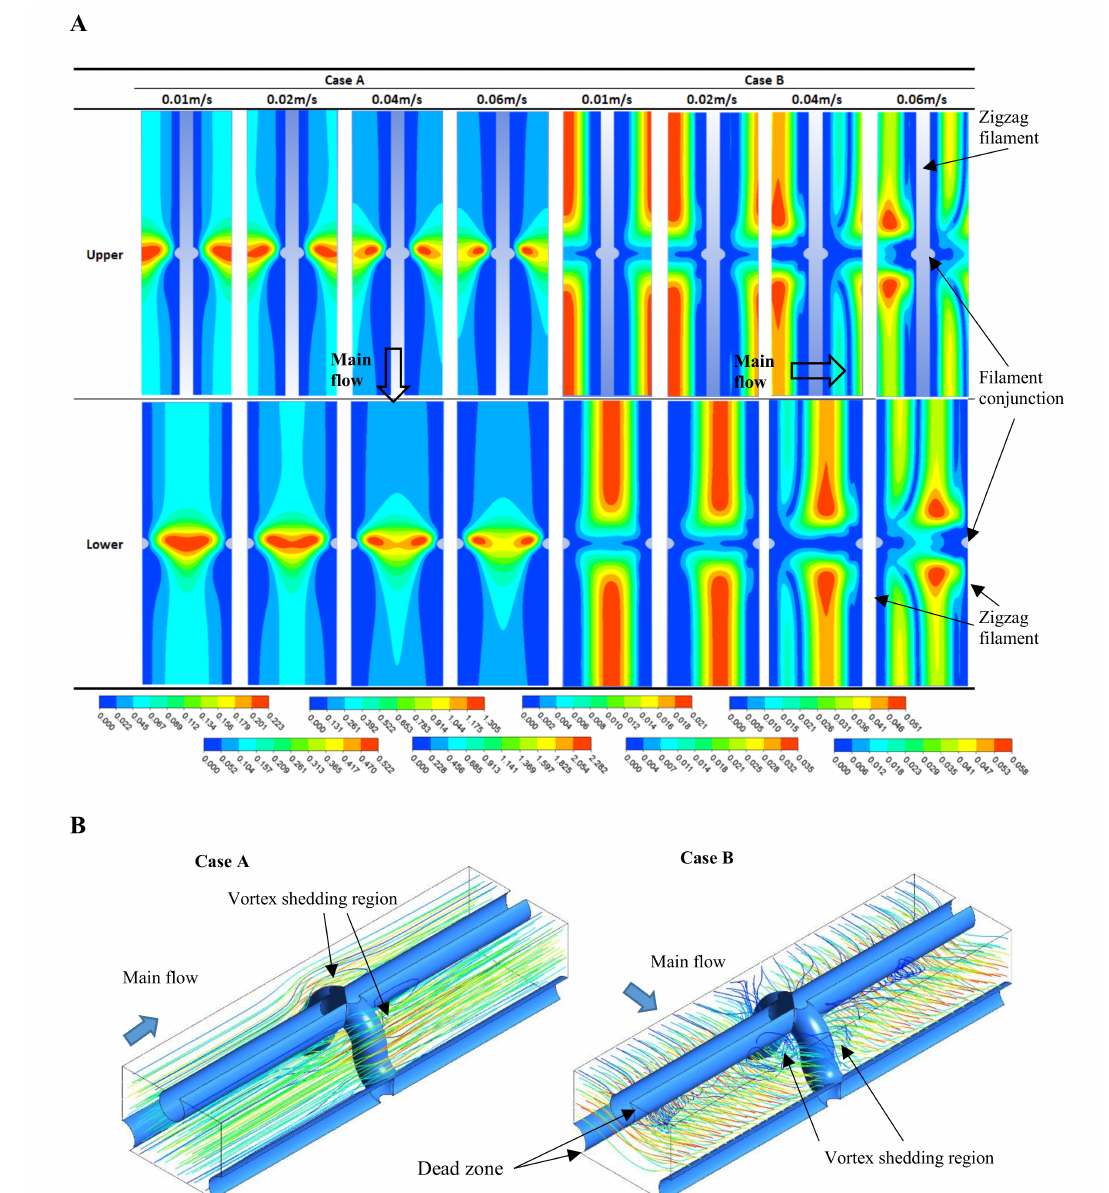
Figure 5. ( A ) Contour plot ( L / D = 12) of the average wall shear stress ( τ ) profile on the upper membrane and lower membrane generated by the spacer; flow was from up to down in case A and flow was from left to right in case B (red: High, blue: Low, unit: Pa); ( B ) streamline of velocity in case A and case B ( L / D = 12, U sup = 0.06 m s − 1